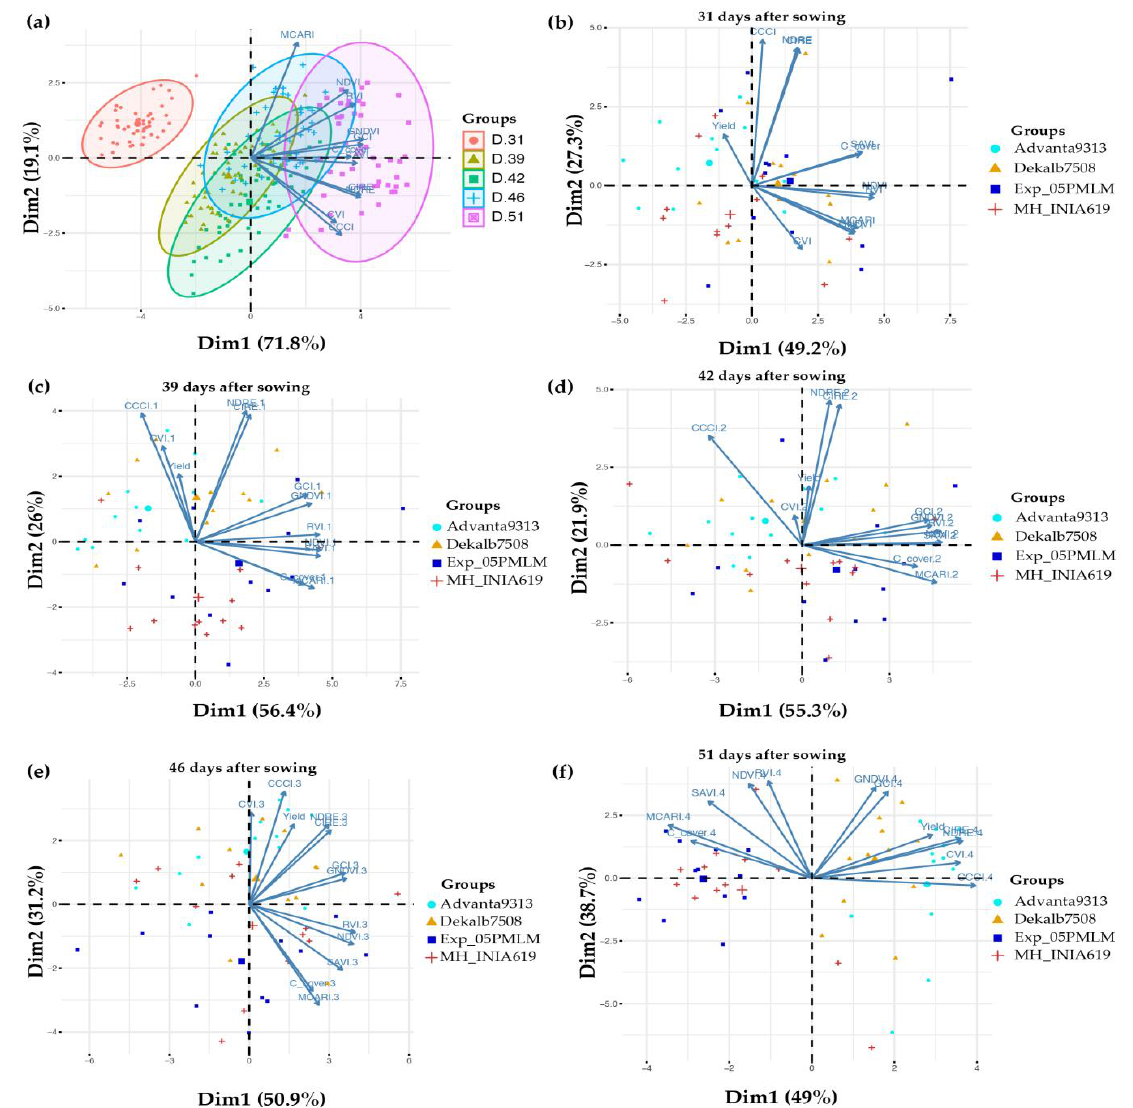
Figure 5. PCA for VIs during the evaluation days: ( a ) PCA for all VIs and DAS; ( b ) PCA for the indices and group of hybrids at 31 DAS; ( c ) PCA for the indices and group of hybrids at 39 DAS; ( d ) PCA for the indices and group of hybrids at 42 DAS; ( e ) PCA for the indices and group of hybrids at 46 DAS; ( f ) PCA for the indices and group of hybrids at 51 DAS.